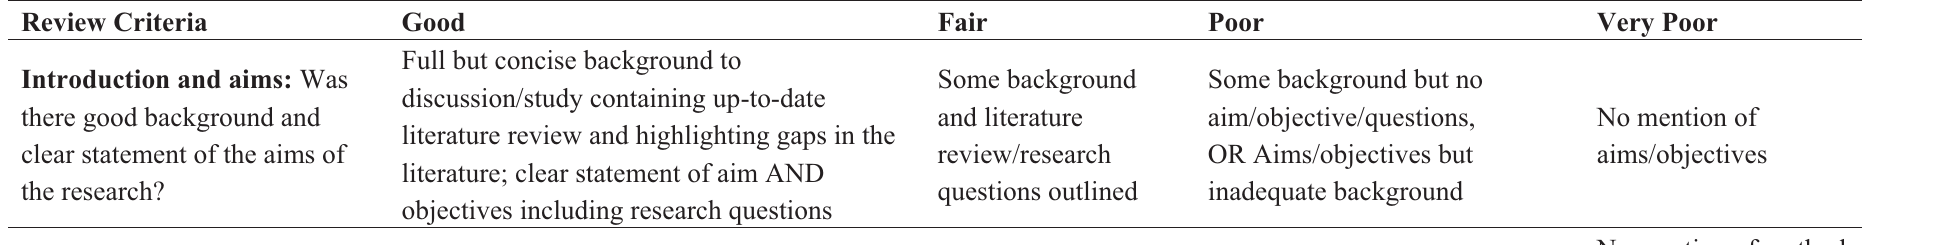
Table 1. Research assessment instrument